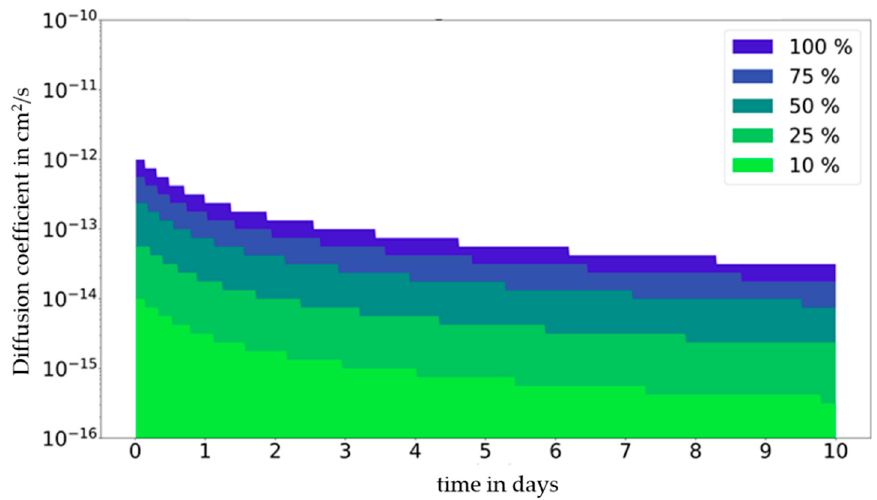
Figure 4. Single-use: Map of time (t) in days against diffusion coefficient (D P ) in cm 2 /s. Deviation of migration in mg in dependence from partition coefficient (K P,F ) expressed in % at a given initial concentration (1000 mg/kg), material thickness (2000 µm), and area to volume ratio (6 dm 2 per kg food).